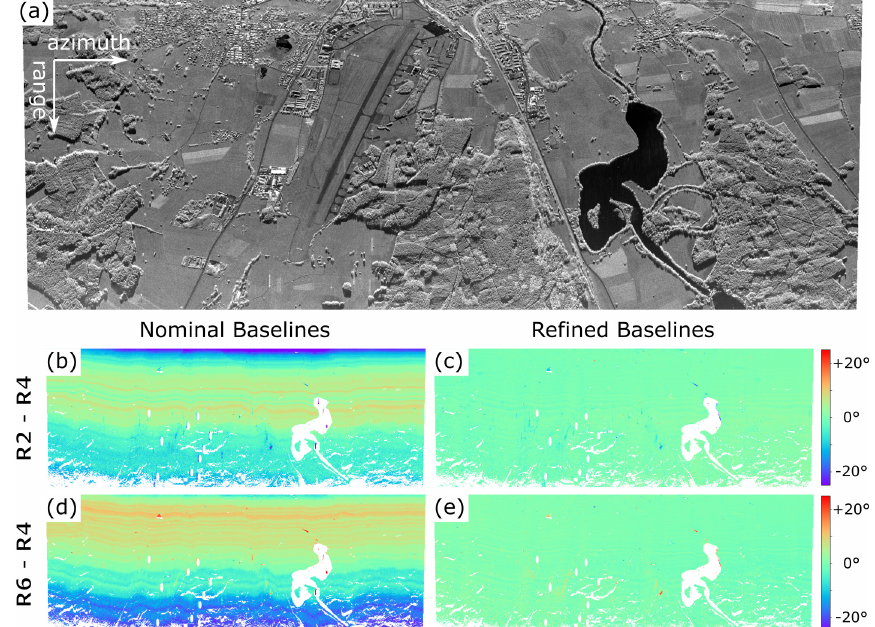
Figure 6. A comparison of residual interferometric phase errors before and after 3D baseline calibration for two different channel combinations. Each colored line represents the range history of a single trihedral reflector in the polar antenna coordinate system. Colors indicate the phase errors measured along the phase history. The columns separate the phase error evaluation before ( a , c ) and after ( b , d ) baseline calibration. The horizontal baseline is annotated on the left side of each row, while the right column includes the 3D baseline correction estimated in the calibration process.The first row ( a , b ) represents a pair of channels with receive antennas 2 and 4, while the second row ( c , d ) corresponds to receive antennas 6 and 4.